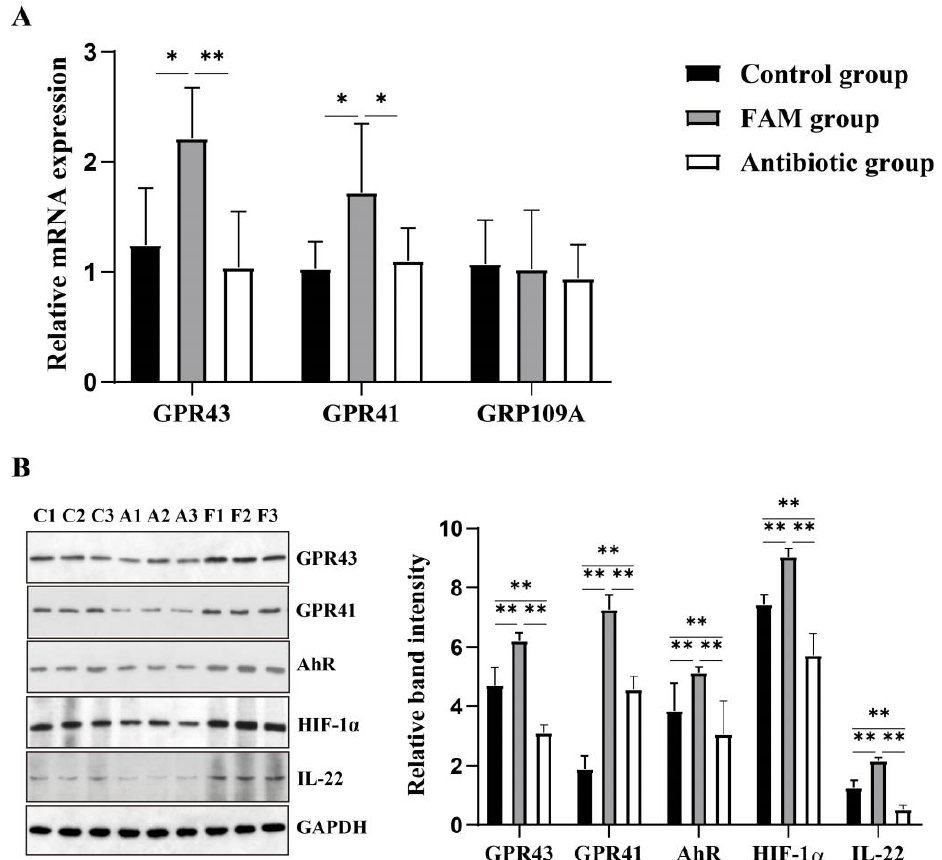
Figure 6. The variation of factors on SCFAs-IL-22 pathway in the colonic mucosa. ( A ) Relative mRNA expression of GPR43, GPR41 and GPR109A in colonic mucosa. ( B ) Relative protein levels of GPR43, GPR41, AhR, HIF-1 α and IL-22 in colonic mucosa. ** p < 0.01, * p <